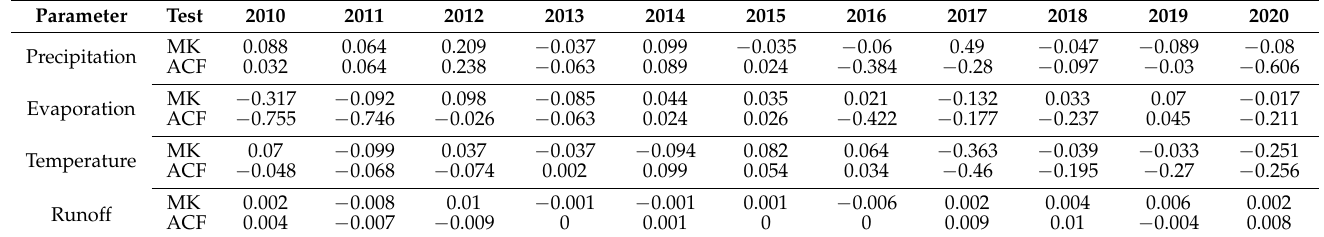
Table 2. Stationarity test of four hydrological parameters from 2010 to 2020 ( p <